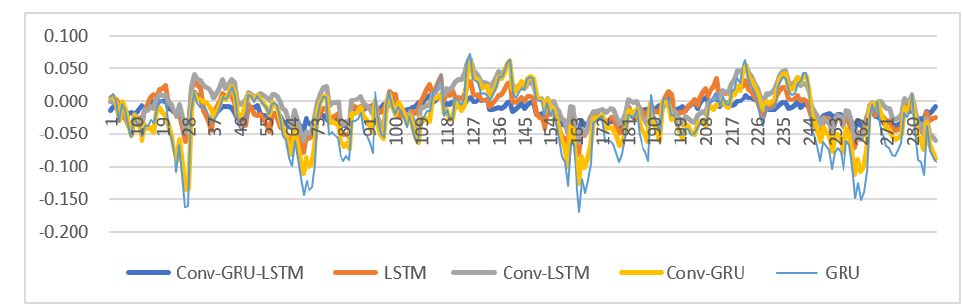
Figure 8. Comparison of prediction results.